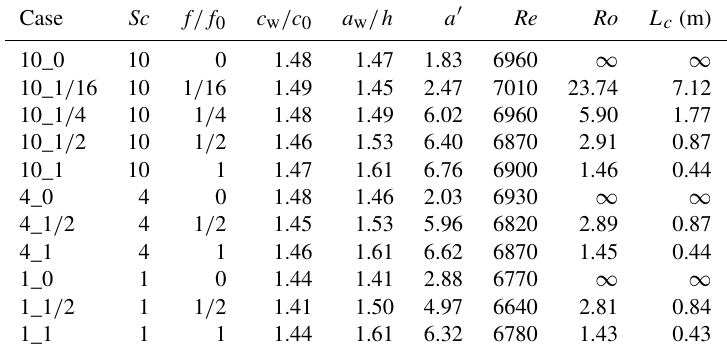
Table 2. Case parameters and characterizations.